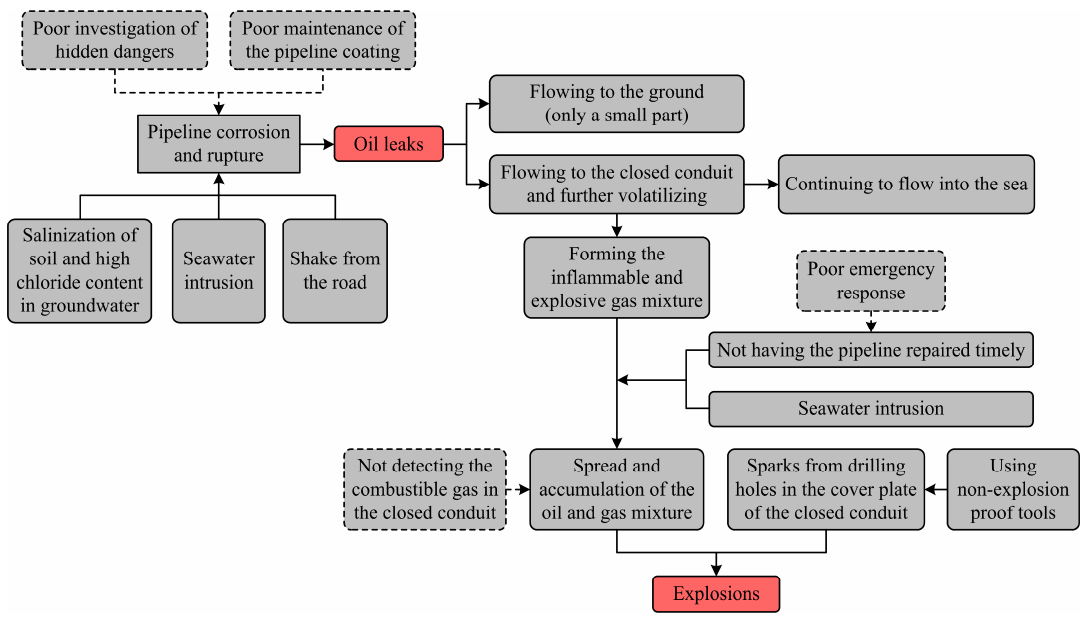
Figure 4. Event sequence diagram ( ESD) of the oil leaks and explosion.